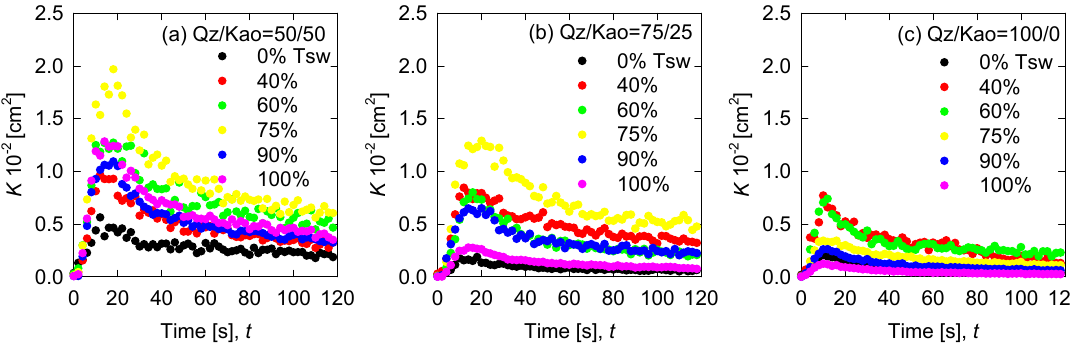
Figure 8. Permeability of aggregates for the mean chord length over time. Quartz/Kaolinite ratio ( a ) 50/50; ( b ) 75/25; ( c ) 100/0.